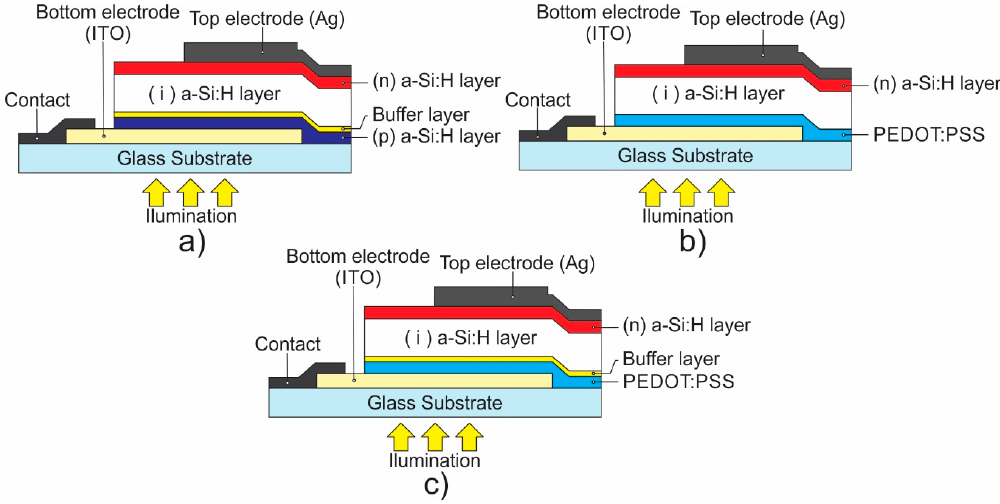
Figure 1. Schematics of ( a ) photovoltaic structure based on amorphous silicon (a-Si:H reference sample), ( b ) superstrate-type hybrid structure (H1) with PEDOT:PSS/a-SiH heterojunction in frontal sample), ( b ) superstrate-type hybrid structure (H1) with PEDOT:PSS / a-SiH heterojunction in frontal interface, and ( c ) superstrate-type hybrid structure (H2) with PEDOT:PSS/buffer/a-SiH heterojunction interface, and ( c ) superstrate-type hybrid structure (H2) with PEDOT:PSS / bu ff er / a-SiH heterojunction in frontal interface. in frontal